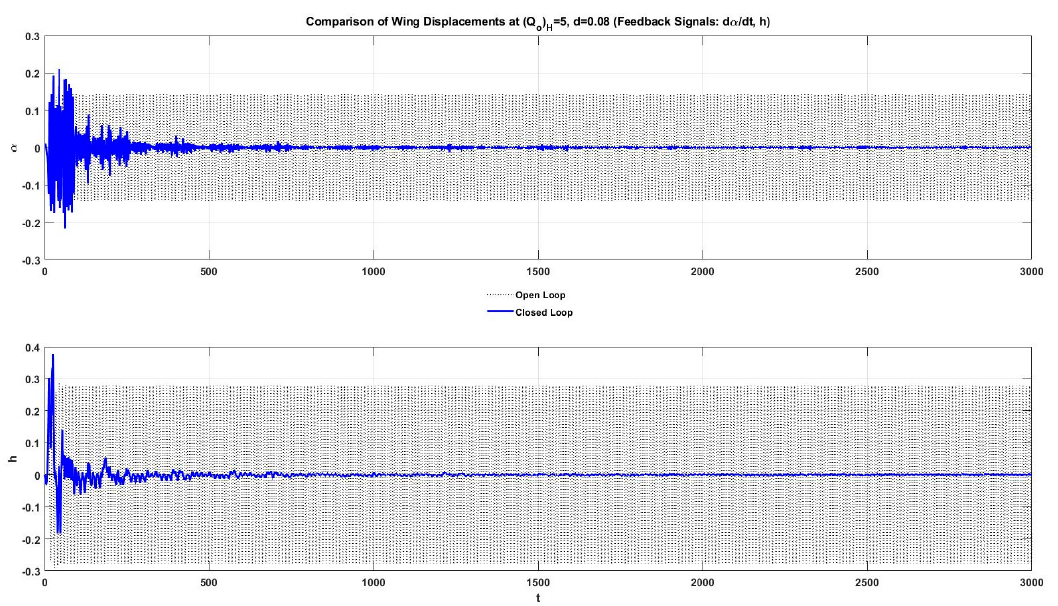
Figure 20. A comparison of aeroelastic responses ( Q o = 5 ) .